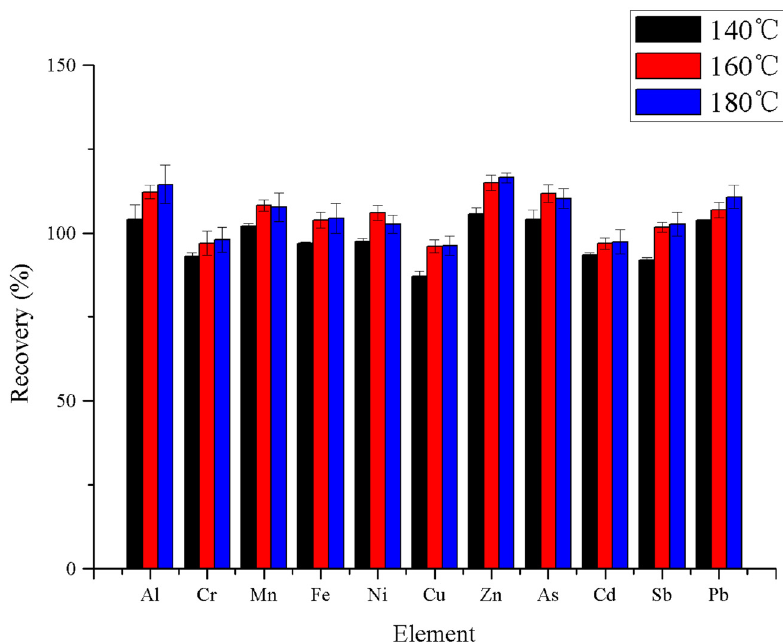
Figure 5: E ff ect of temperature on the recovery of each element in